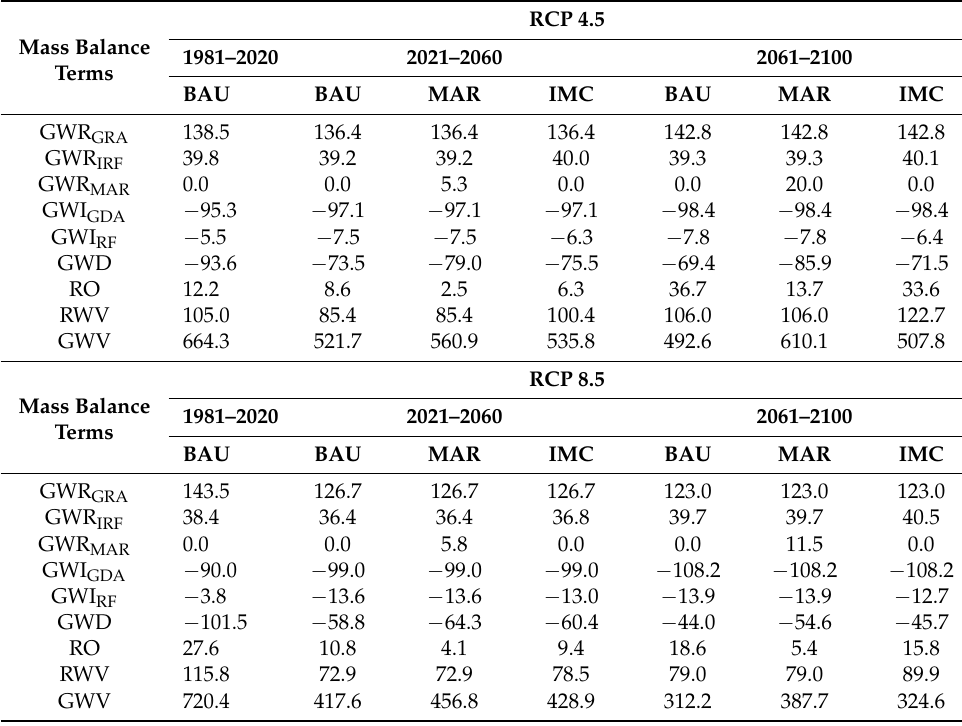
Table 4. Annual cumulated mean water volume (10 6 m 3 ) of each term of the groundwater mass balance (GWR GRA , GWR IRF , GWR MAR , GWI GDA , GWI RF and GWD) and for the reservoir total overflow (RO) and mean water volume (10 6 m 3 ) for the surface reservoir (RWV), and the groundwater (GWV)